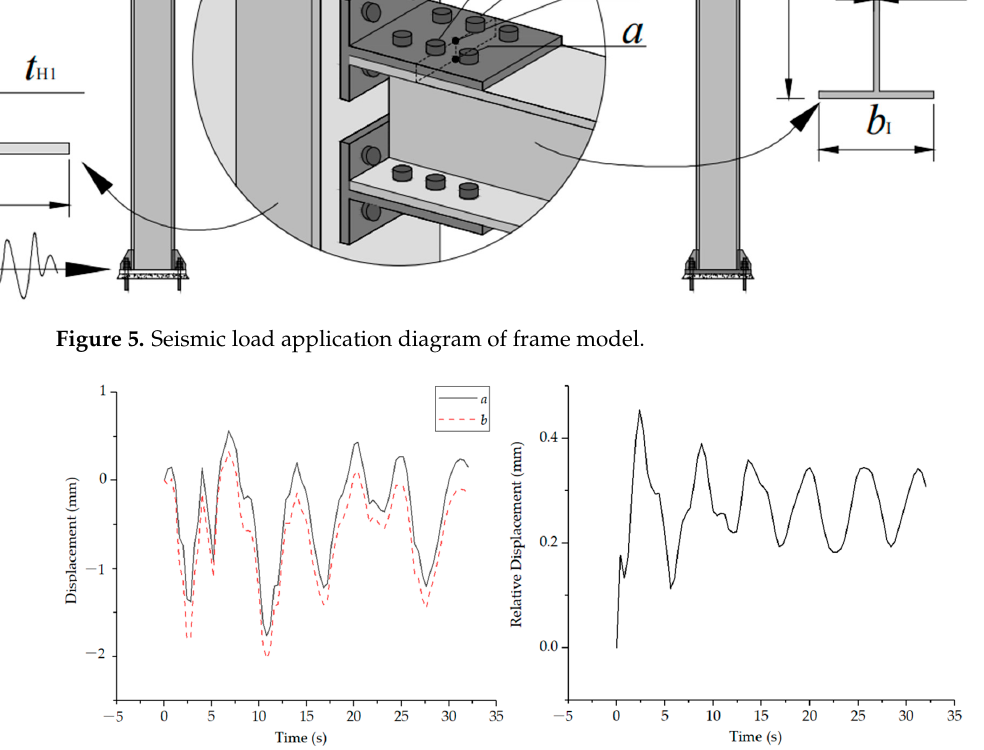
Figure 5. Seismic load application diagram of frame model.